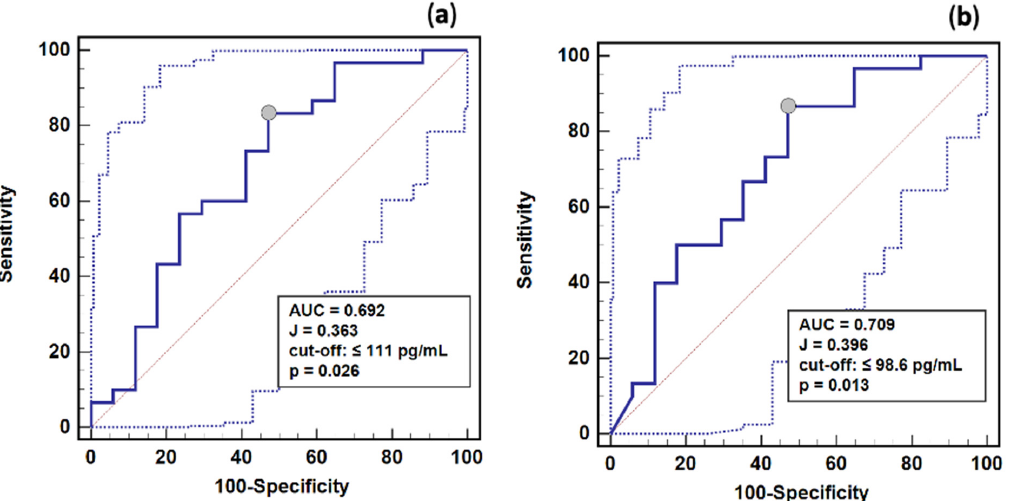
Figure 7. Renin as a 28-day survival marker (blue line): ( a ) determined on the third study day; ( b ) determined on the fifth study day. Legend: Dotted lines—95% CI. Notes: Data were analyzed using receiver operating characteristics (ROC) curve analysis. AUC, area under ROC curve, interpreted as marker’s overall accuracy; J, Youden index.